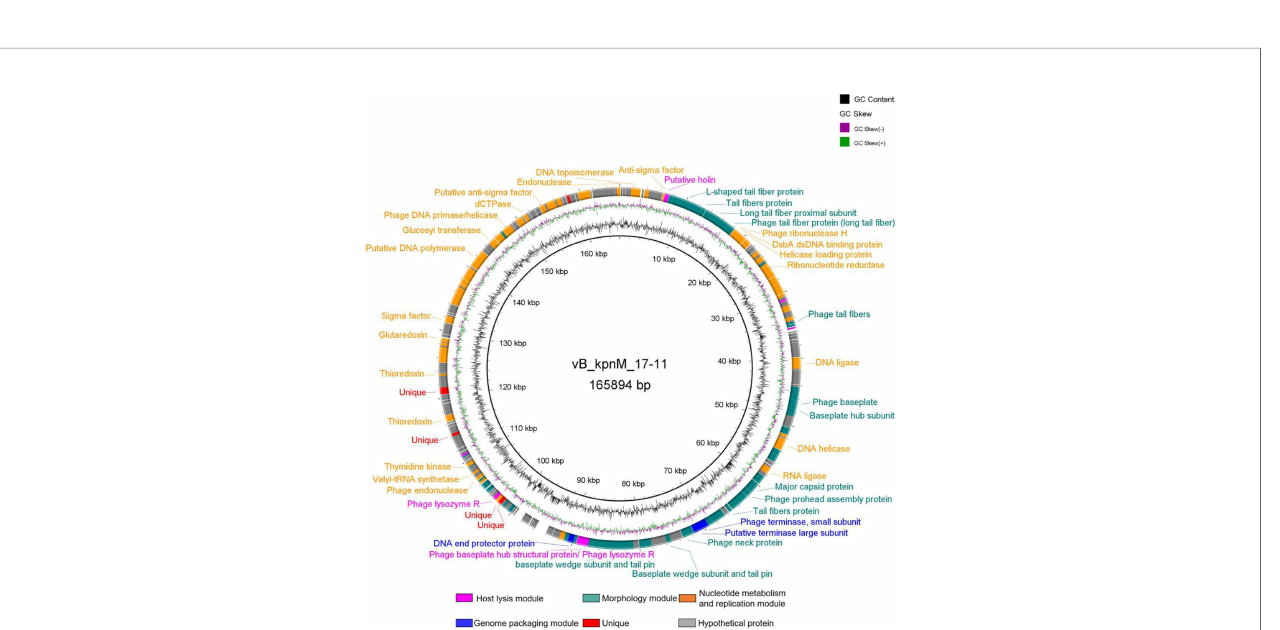
FIGURE 5 | Genome map of phage vB_kpnM_17-11. The black circle in the middle represents the GC content; the violet circle represents GC skew. Different colors represent genes with different functions: peach for host lysis module, green for morphology module, orange for nucleotide metabolism and replication, blue for packaging module, red for speci fi c protein, gray for hypothetical